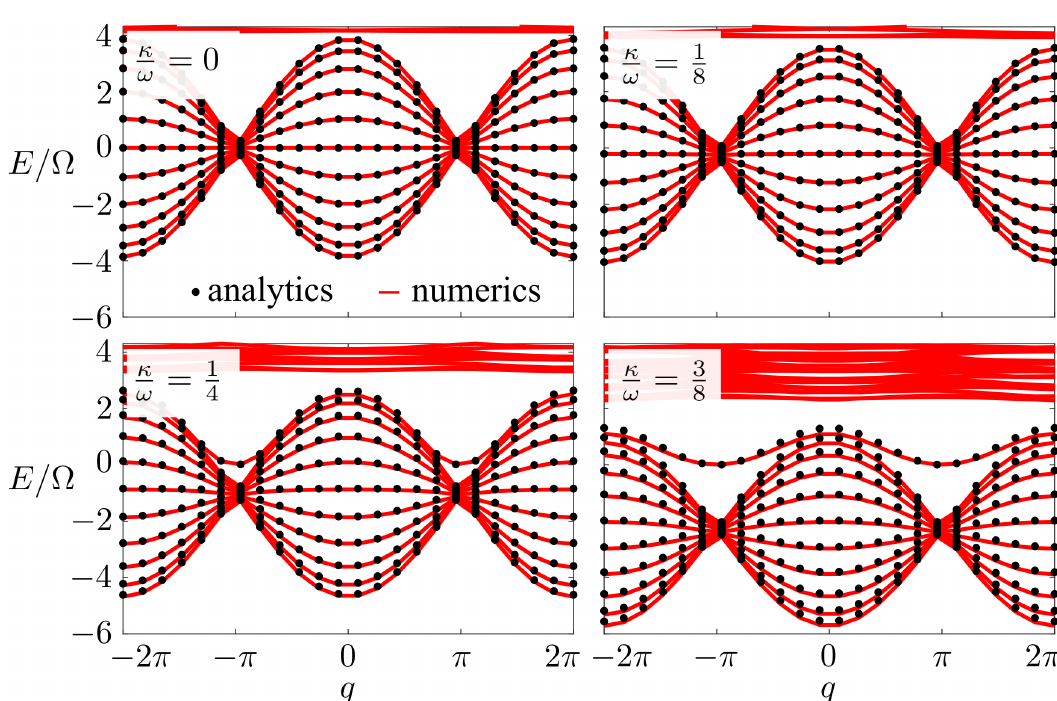
Figure 2: Vibrationally dressed band structure of a single Rydberg cluster : En- ergy bands in the free case ( κ = 0) and with phonon dressing ( κ (cid:54) = 0). Red lines are obtained through numerical diagonalization of Hamiltonian (7) with N = 12 sites and a truncation of the maximum number of phonons per site to 3. Black dots are the eigenvalues of the effective Hamiltonian (11) which has been obtained by integrating out the phonon degrees of freedom. The trap and Rabi frequencies are chosen such that ω = 8 Ω . Note that, as κ/ω increases, the center of the band gets lower in energy. This is due to the presence of the constant term in Eq. (11) which is equal to − 2 κ 2 /ω and is naturally included in the numerical diagonalization of Hamiltonian